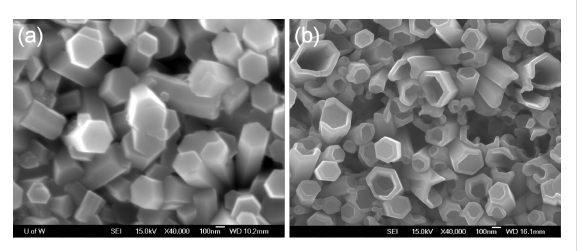
Figure 7: SEM images of (a) ZnO nanorods grown at 90 °C for 3 h and then 60 °C for 5 h, and (b) nanotubes grown at 60 °C for 5 h in a solu- tion which was, however, pretreated at 60 °C for 1 h and then 90 °C for 2